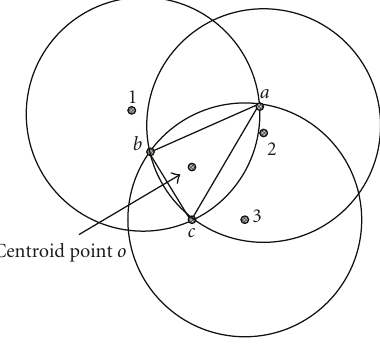
Figure 6: An example to describe the centroid point of a shared region. The intersection points of the shared region sr f points a , b , and c . Then the centroid point o of the triangle abc is regarded as the position of any RN that is placed within SR f